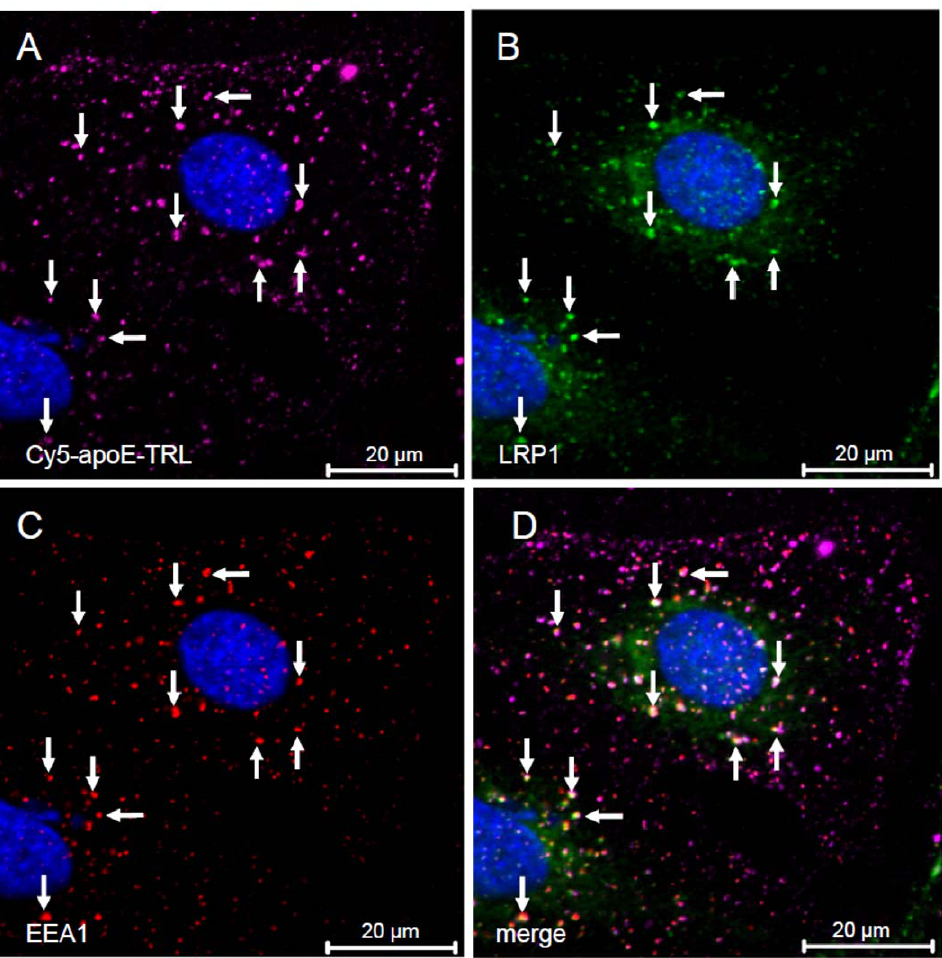
Figure 3. Internalized TRL-derived apoE co-localizes with LRP1 in EEA1-positive endosomes. HuH7 cells were incubated with Cy5-apoE- TRL for 10 min at 37 u C. As indicated by the arrows, subsequent immunofluorescence analysis revealed co-localization of apoE (A) with LRP1 (B) in EEA1-positive endosomes (C). The merged image is shown in D. Nuclei were visualized by DAPI and appear in blue. Bar is 20 m m.